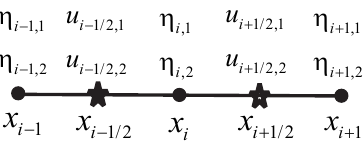
Figure 3. Illustration of the staggered grid with configuration of the calculated variables η 1 , η 2 and u 1 , u 2